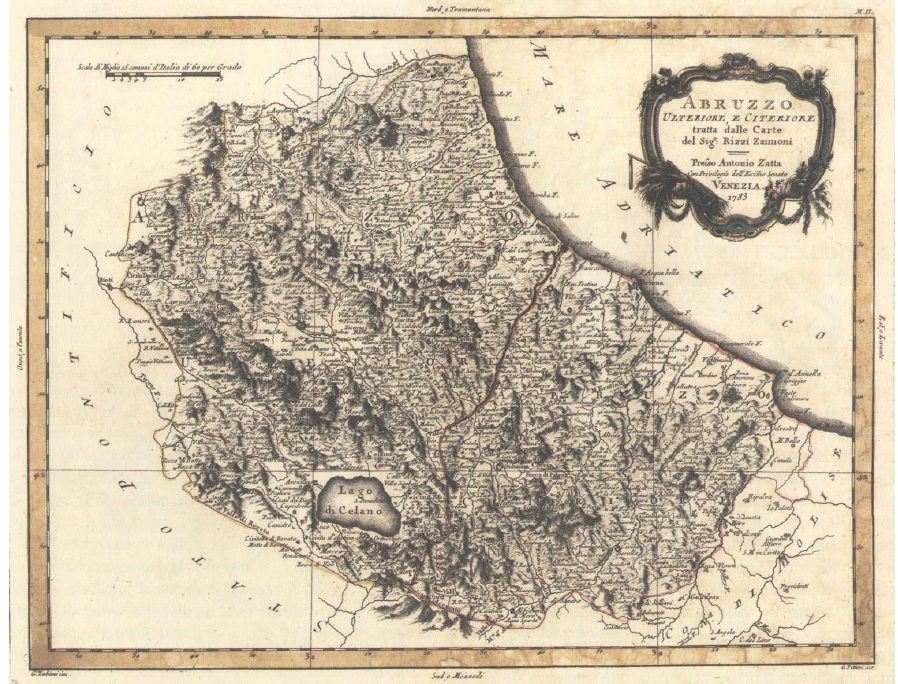
Figure 13. Antonio Rizzi Zannoni, Abruzzo and Citeriore Further , printed by Antonio Zatta, Venice (1783), 500 × 390 mm, paper, Archives Collection of Pescara State (Private Archive of Genova,